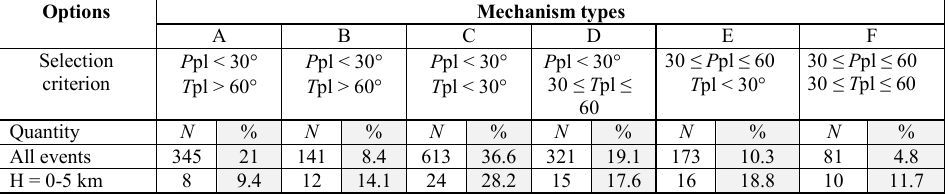
Table 1. Criteria for choosing the type of mechanism, the number of earthquakes according to the criterion for choosing the type of mechanism for the entire catalogue and for individual depths